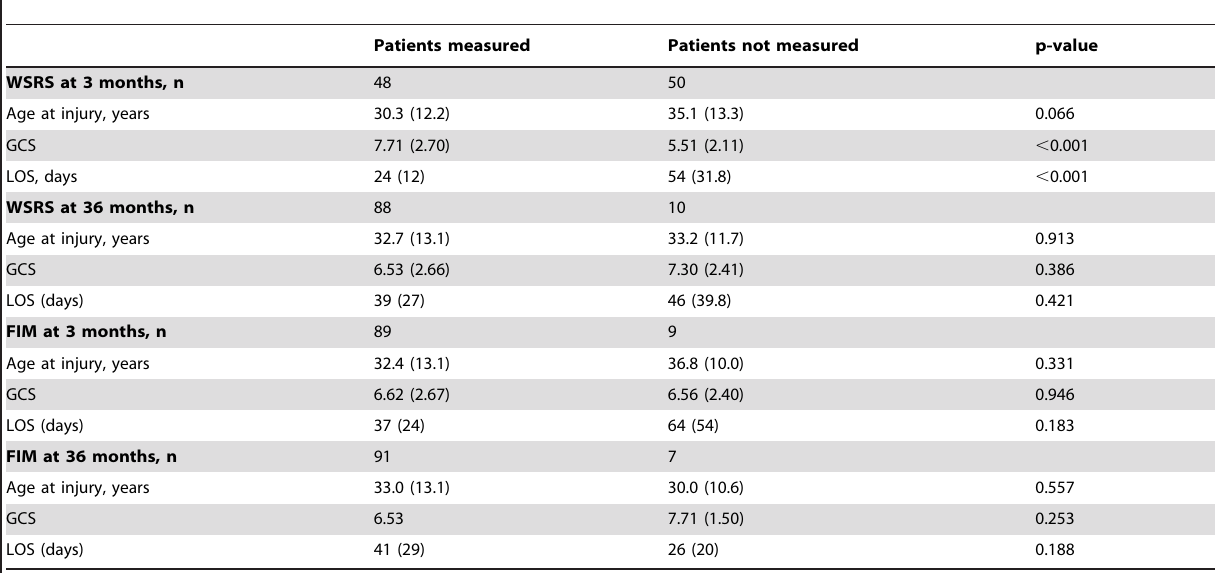
Table 4. Comparison between characteristics (mean (SD)) of patients measured and of patients not measured at 3 and 36 months after